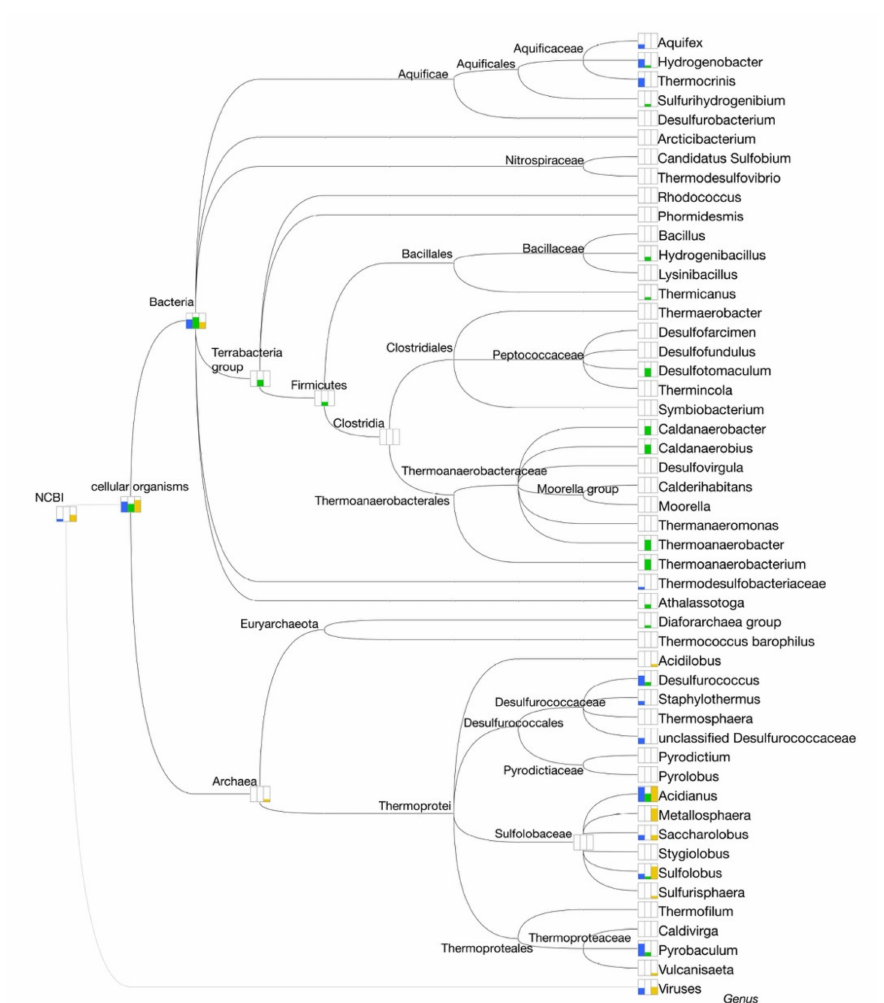
Figure 8. Taxonomic assignment of the CAZymes identified in sites A, B, and C. The filled area of the rectangle indicates, on a logarithmic scale, the number of ORFs assigned to each